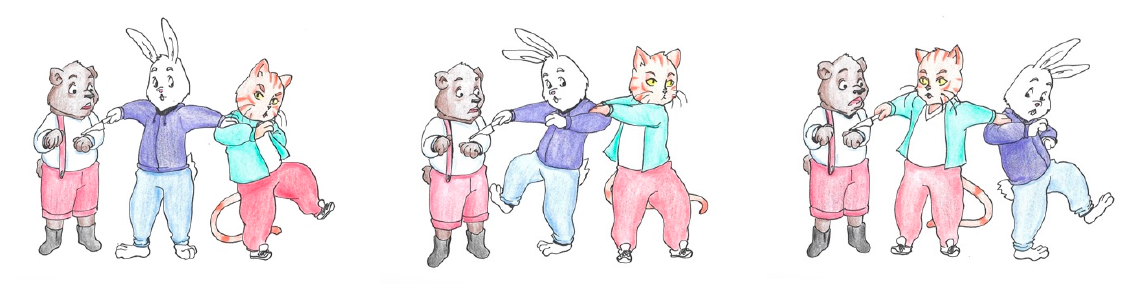
Figure A20. ORC stimulus 5.